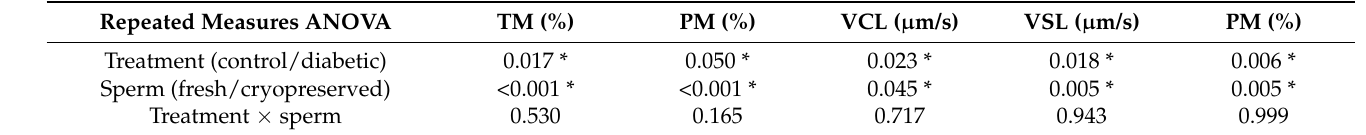
Table 1. Statistical analysis of sperm motility parameters (data recorded for 1 min, each 10 s post- activation) in Tg( ins : nfsb-mCherry ) zebrafish under control and diabetic conditions and their interac- tions ( p -values).